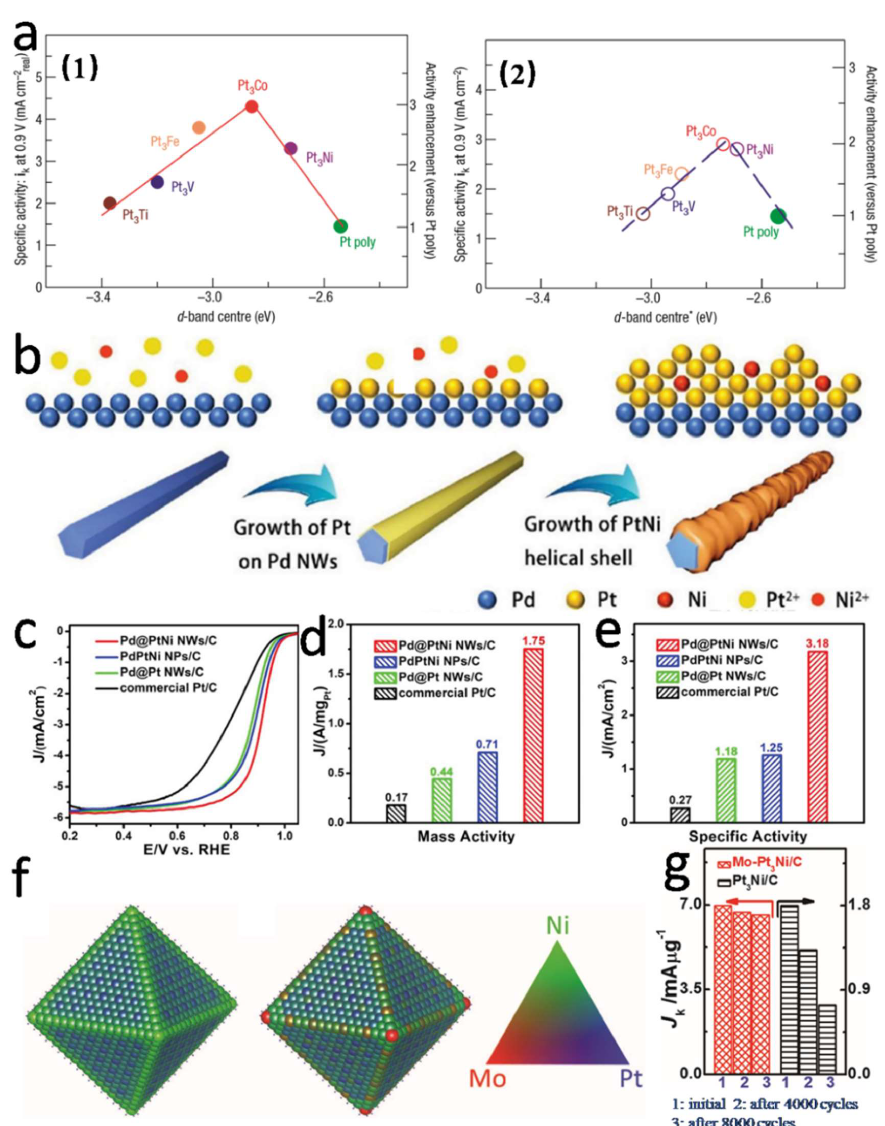
Figure 7. ( a ) The relationships between experimental specific activity of ORR on the Pt 3 M surface in 0.1 M HClO 4 at 333 K and the location of d-band centers on the surfaces of Pt-skin ( a1 ) and Pt-skeleton ( a2 ). Reproduced from ref. [125] with permission from Springer Nature, copyright 2007. ( b ) Schematic illustration of Pd@PtNi NWs; the ORR activities of commercial Pt/C, Pd@Pt NWs/C, PdPtNi NPs/C and Pd@PtNi NWs/C: ( c ) LSV curves, ( d ) mass activities and ( e ) specific activities at 0.9 V. Reproduced from ref. [120] with permission from Wiley-VCH. copyright 2019. ( f ) Average site occupancies of Mo 73 Ni 1143 Pt 3357 NC determined by Monte Carlo simulation; ( g ) catalytic activities of the Pt 3 Ni/C and Mo-Pt 3 Ni/C catalysts after ADT cycles. Reproduced from ref. [72] with permis- sion from Science, copyright 2015.